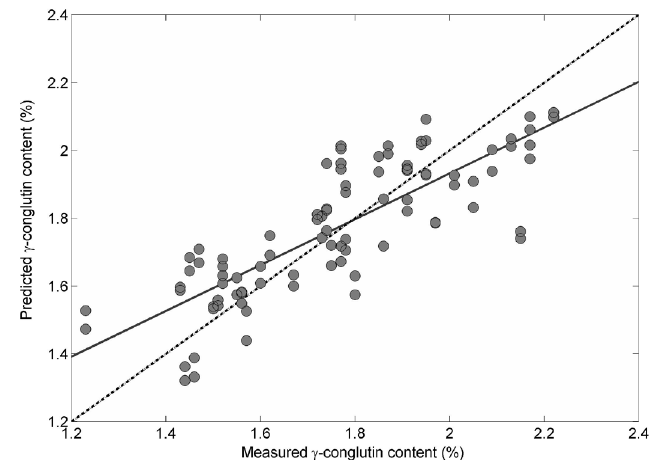
Fig. 1: Scatter plot of measured vs. predicted seed γ -conglutin content (in % w/w) for 46 genotype-environment combinations. Prediction based on a Near-Infrared Reflectance spectroscopy calibration curve, using cross-validations (continuous line = regression line; broken line = 1:1